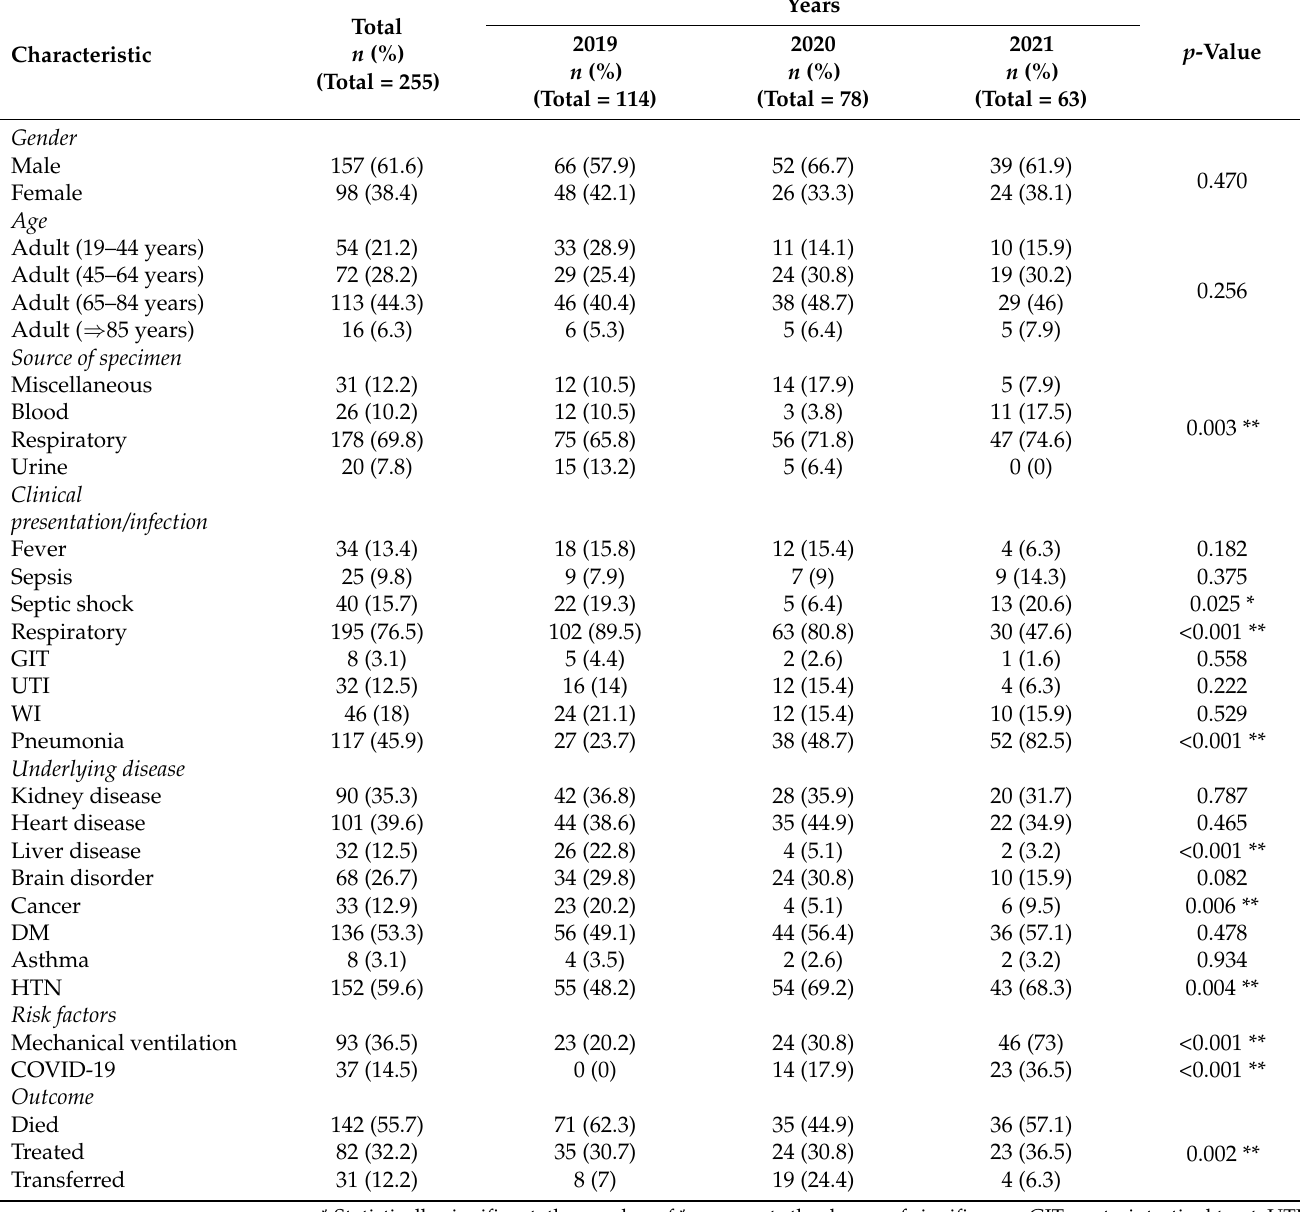
Table 3. Characteristics of ICU patients with multi-resistant P. aeruginosa infection for the period